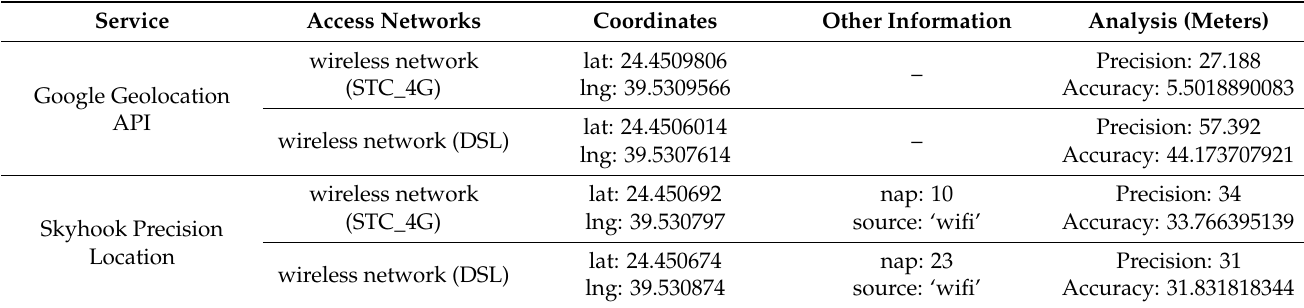
Table 14. Result and Comparison of WPS in Figure 8. Experiment images. ( a ) PNG image with size 205 KB; ( b ) PNG image with size 3.22 KB.